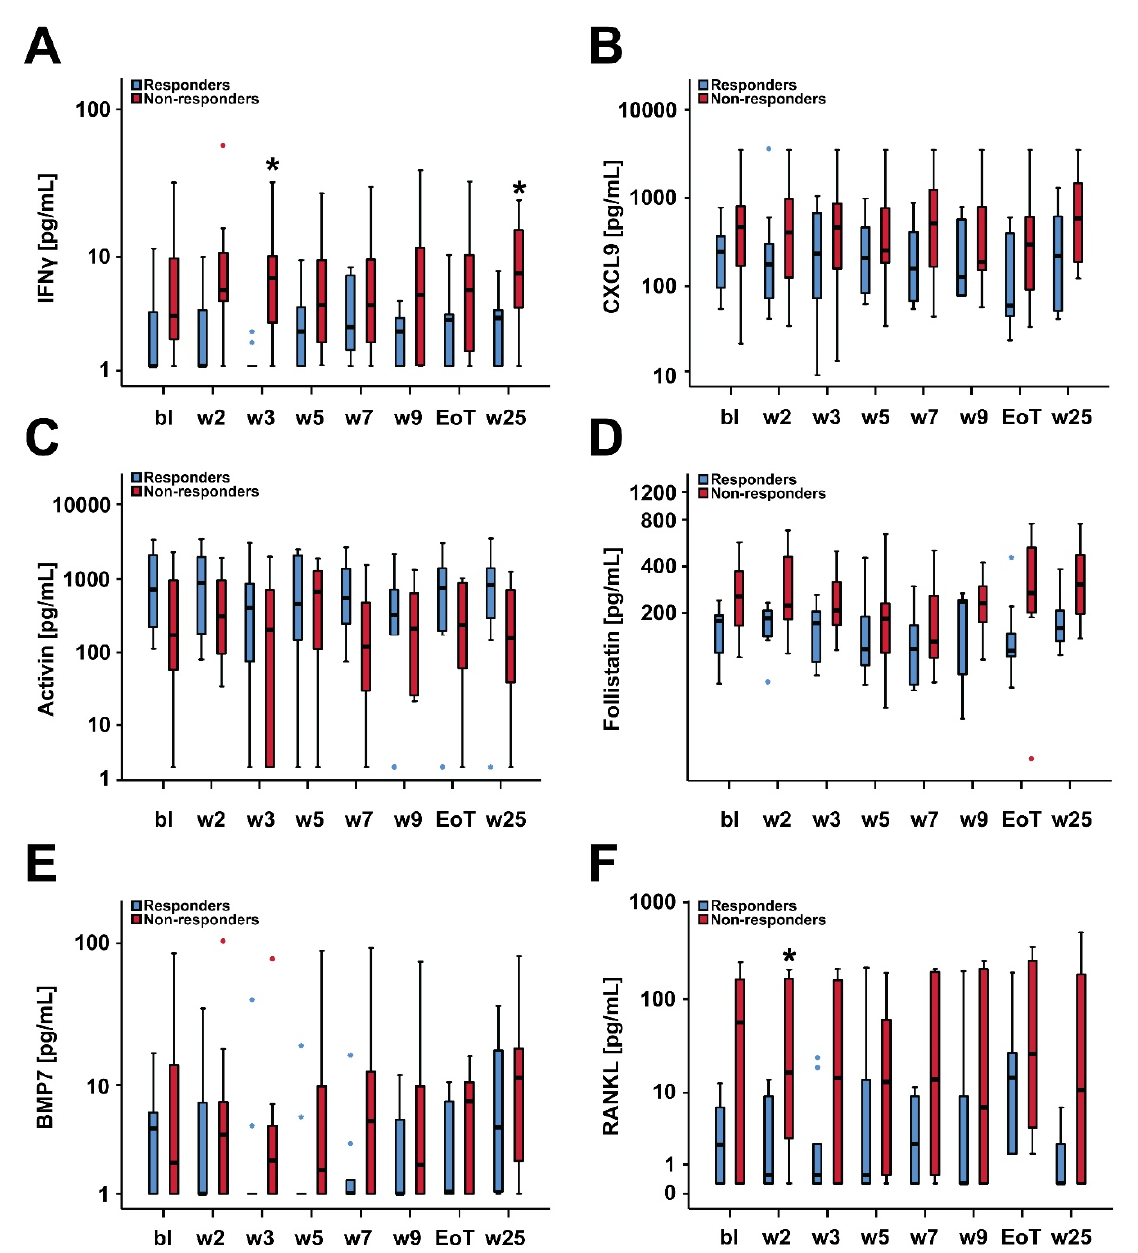
Figure 3. Box plot diagrams of serum levels of IFN γ ( A ), CXCL9 ( B ), activin ( C ), follistatin ( D ), BMP7 ( E ) and RANKL ( F ) in responding (n = 9) versus non-responding (n = 10) patients at defined study visits. Median serum biomarker levels were compared in responding versus non-responding patients applying the Mann–Whitney test (* p < 0.05). Abbreviations: bl, baseline; w, week; EoT, end of treatment (i.e., week 13 visit).